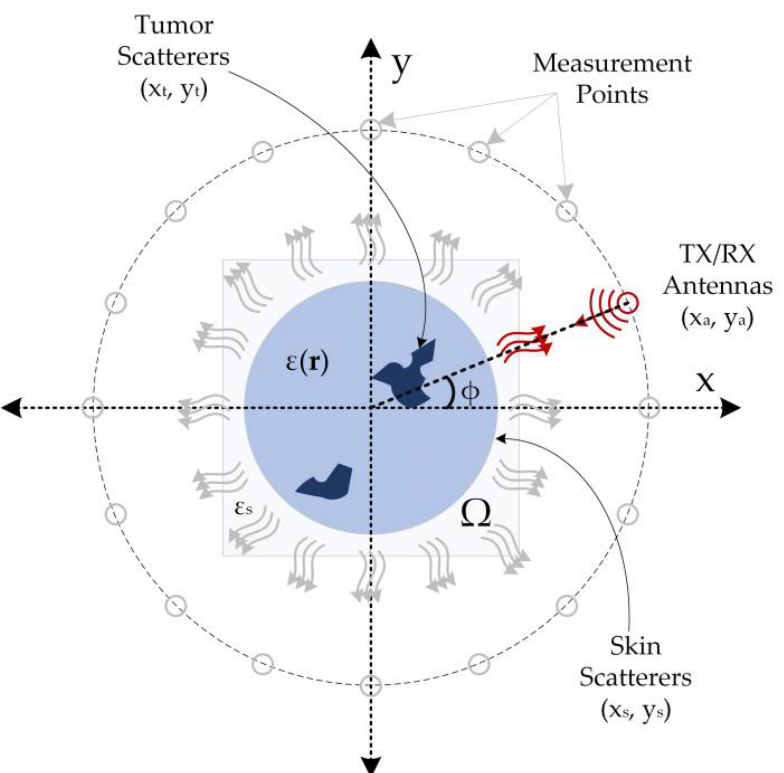
Figure 1. Simulation setup for two-dimensional breast tumor imaging (The red arcs from the antenna to the imaging field represent the propagating wave, the gray arrows the scattered field, and the red arrows the backscattered field).